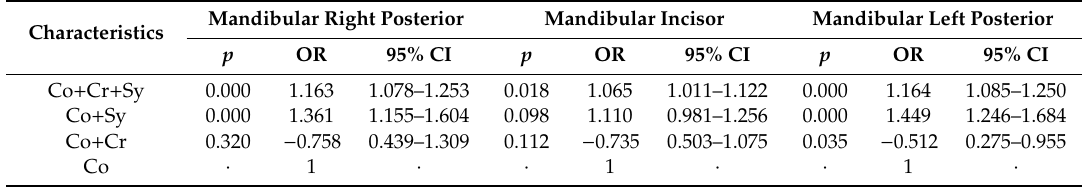
Table 4. CPI of Mandibular by Region and Co ff ee